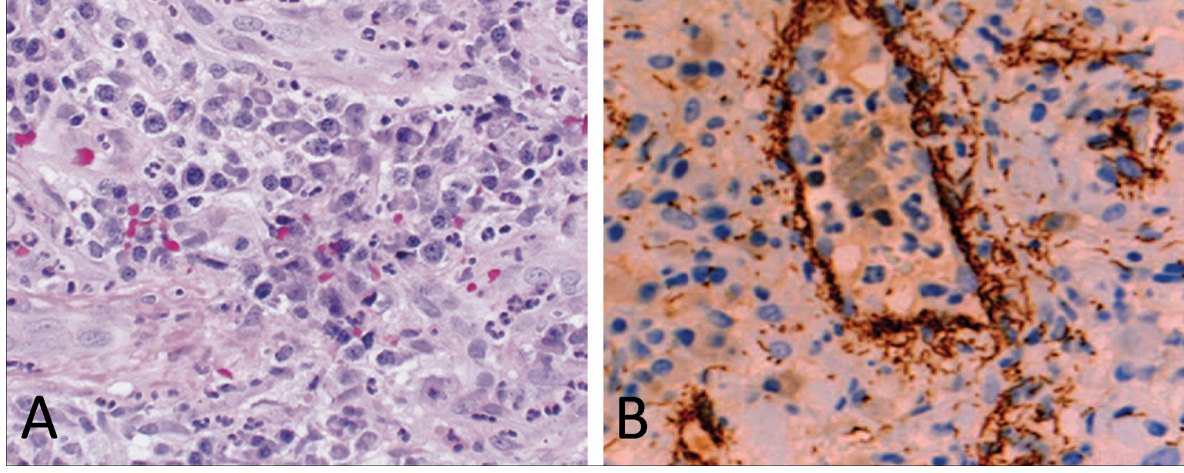
Fig. 2. Pathological and immunohistochemical results for the rectal chancre . (A) Hematoxylin and eosin staining of rectal biopsy specimen. Rectal mucosa with dense infiltration by monocytes and plasmocytes ( × 400). (B) Immunohistochemical staining for T. pallidum showing numerous typical spiral and thread-like organisms highlighted by brown chromogen in the rectal biopsy specimen, especially around the small vessels ( ×